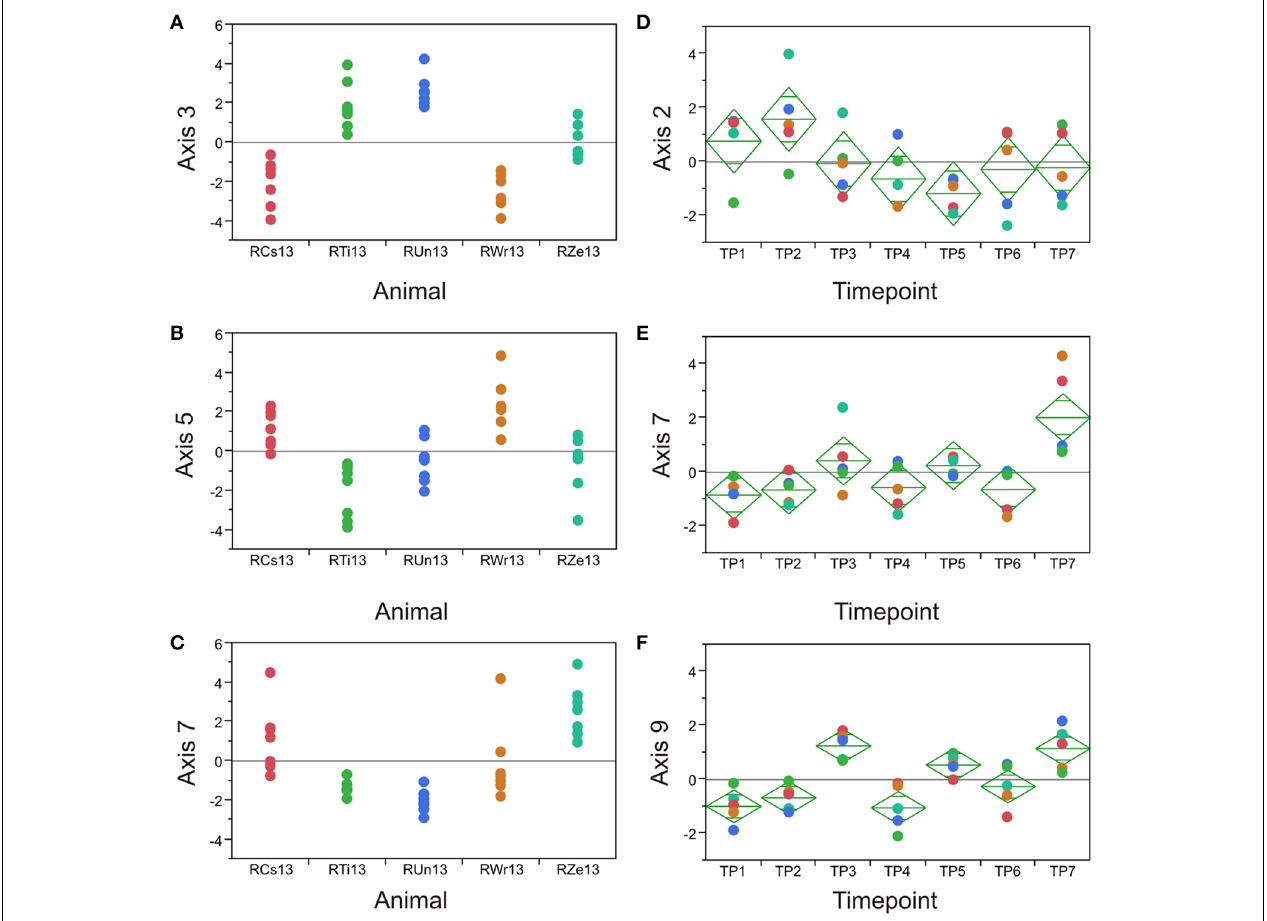
FIGURE 5 | Axis of variance analysis. Each plot shows the indicated Axis score (PC1 of the 10 BIT for the Axis) in the five animals (A–C) or at the seven timepoints (D–F) . In bone marrow, Axes 7 and 9 are significantly differentiated at TP3, 5, and 7, the post-drug timepoints.